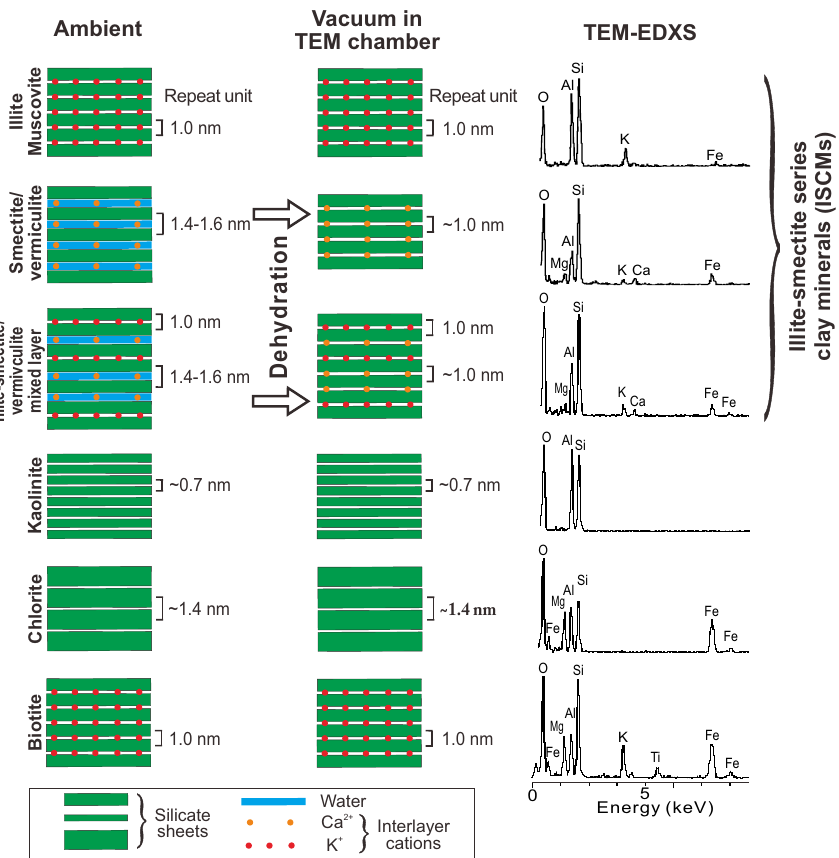
Figure 1. Identification criteria of clay minerals based on the spacing of repeat units measured from a TEM lattice fringe image (left two columns) and EDXS spectra (right column). Repeated stacking of silicate sheets in clay minerals viewed along the crystallographic a–b